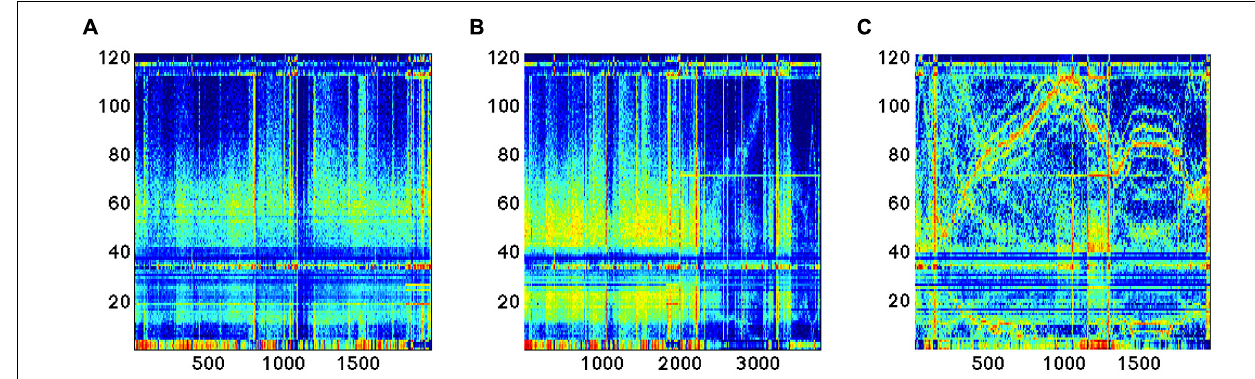
FIGURE 5 |Time series of the 121 features analyzed during EEG recording in three different conditions: (A,B) sleep; (C) dream activity.